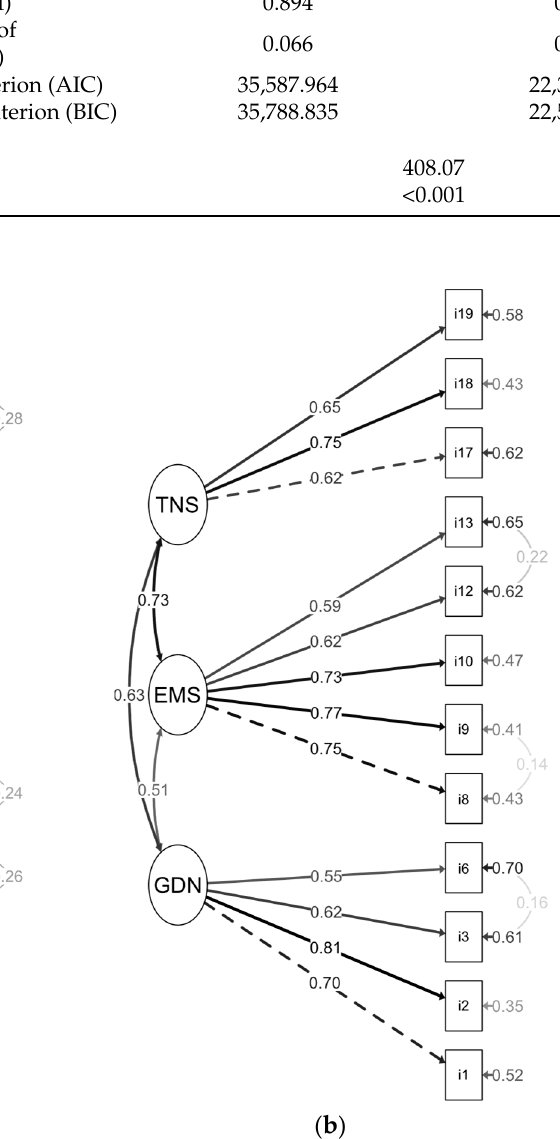
Figure 1. Path diagrams for the confirmatory factor analysis. The diagrams show standardized regression weights, inter-factor correlations, standardized item variances and selected correlated errors for ( a ) original model and ( b ) alternative model. Abbreviations: GDN—Guidance, EMS—Emotional support, TNS—Tangible support. Table 2. Validity and reliability of the original and alternative model.